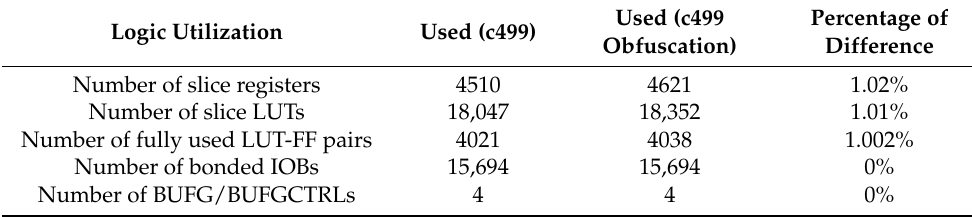
Table 2. Consumption of space overhead in the proposed method (SILL).